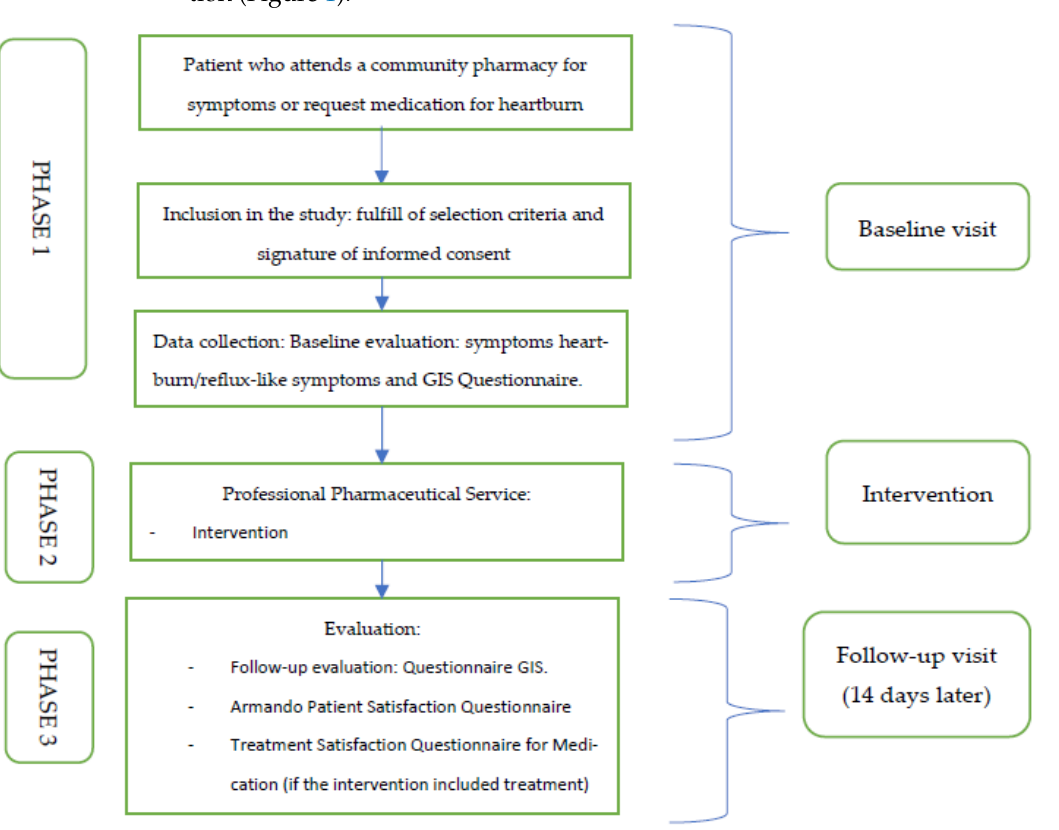
Figure 1. Description of the study